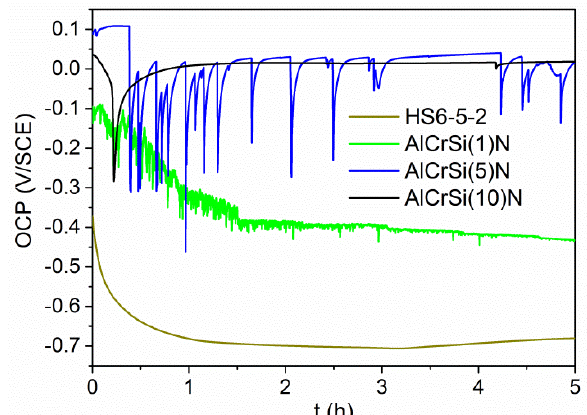
Figure 13. Open circuit potential (OCP) changes monitored during the five-hour stabilization of the HS6-5-2 and HS6-5-2 / AlCrSiN systems in the electrolyte solution For the respective samples, it was found: